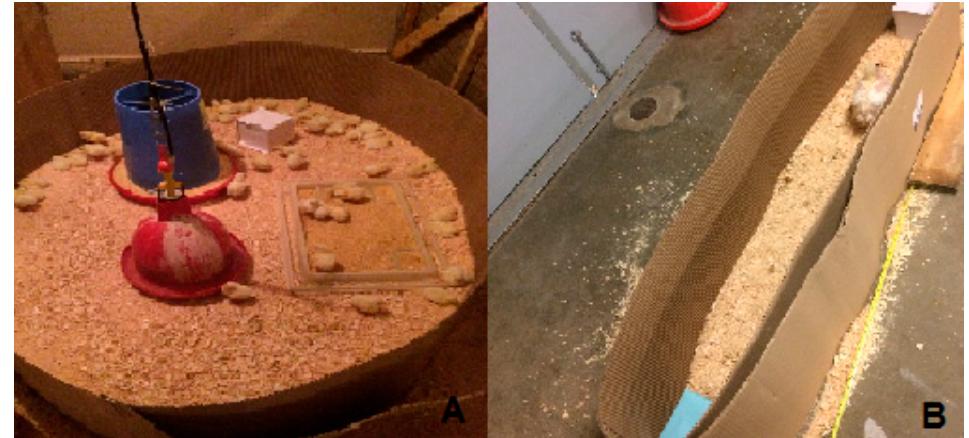
Figure 1. The examples of the object memory test. ( A ) During the imprinting phase from 1 to 7 day, a white block was placed inside each pen; and ( B ) during the test phase at 15 day, the tested bird was placed at the middle of the runaway board with the randomly placed imprinted object (white block) and a novel object (blue block) at one of its ends (16 birds per treatment).